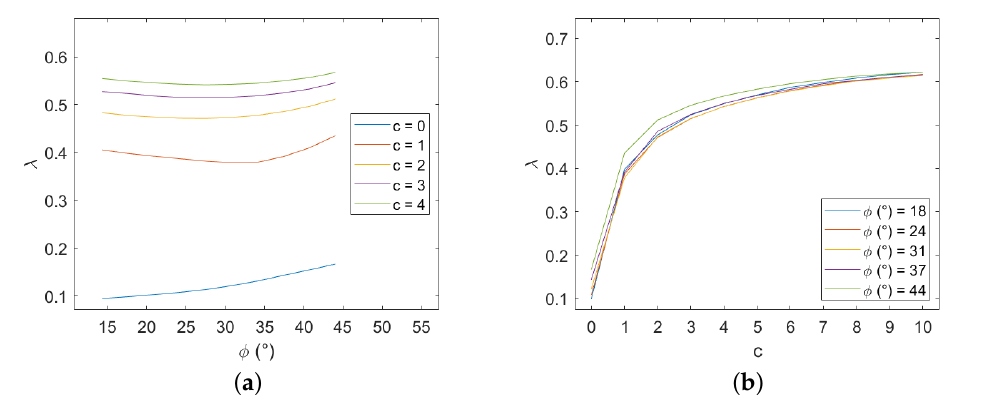
Figure 20. Periodic masonry, failure multiplier for different values of cohesion c and internal friction angle ϕ of the blocks: ( a ) effect of variation of ϕ for different values of c , ( b ) effect of variation of c for different values of ϕ